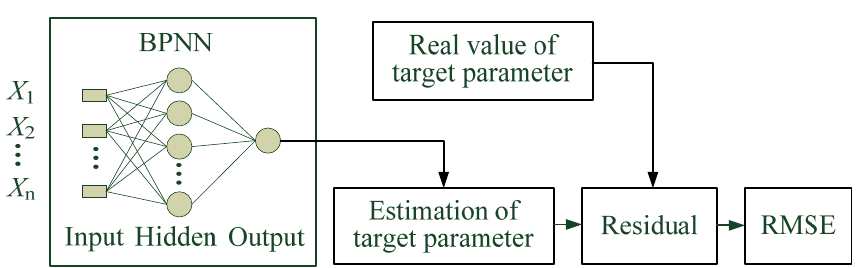
Figure 5. Sketch of the